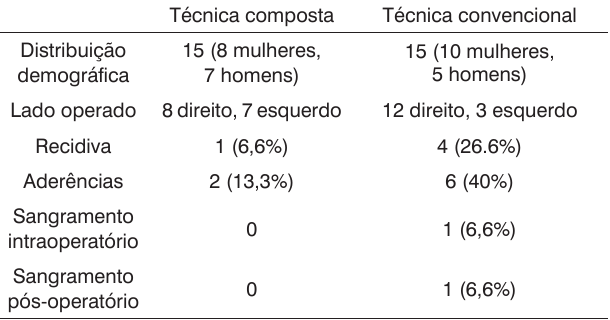
Tabela 1. Comparação entre as duas